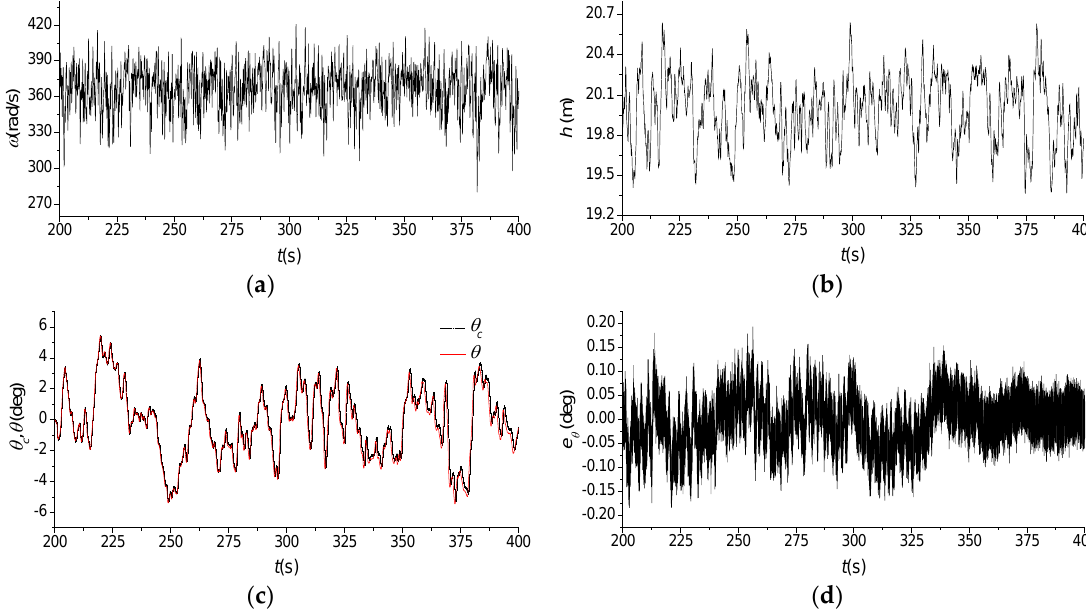
Figure 12. The experimental results using the existing adaptive controllers in the altitude loops, and the PID controller without the closed-loop rotational speed control structure in the altitude loop: ( a ) ω ; ( b ) h ; ( c ) θ c and θ ; ( d ) e θ .